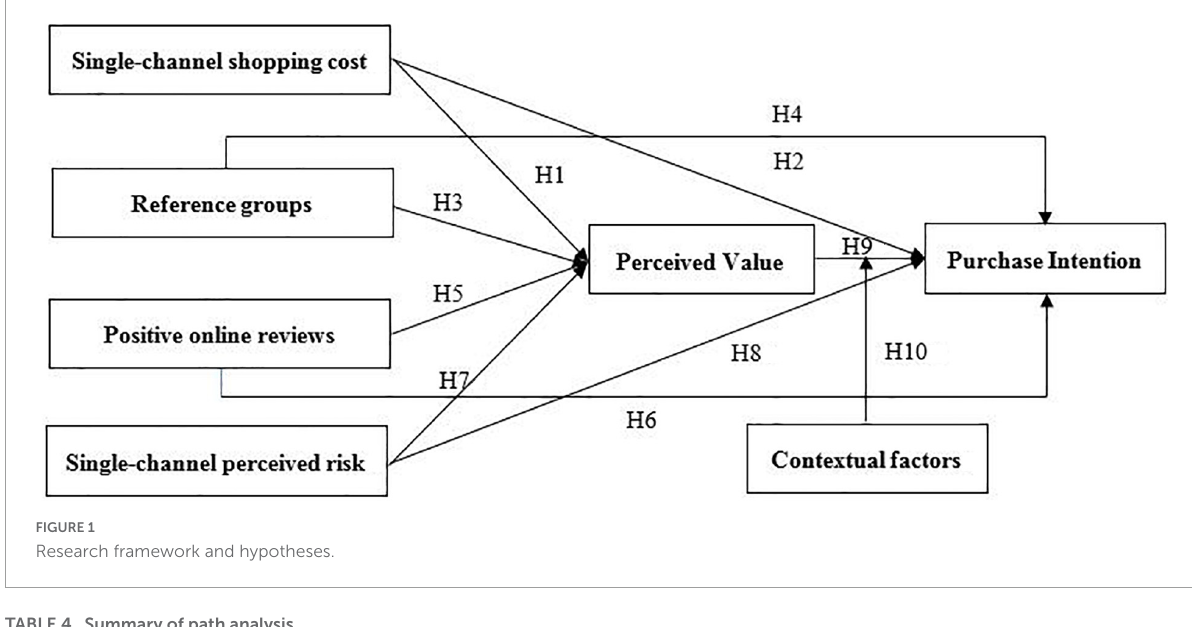
TABLE 4 Summary of path analysis.